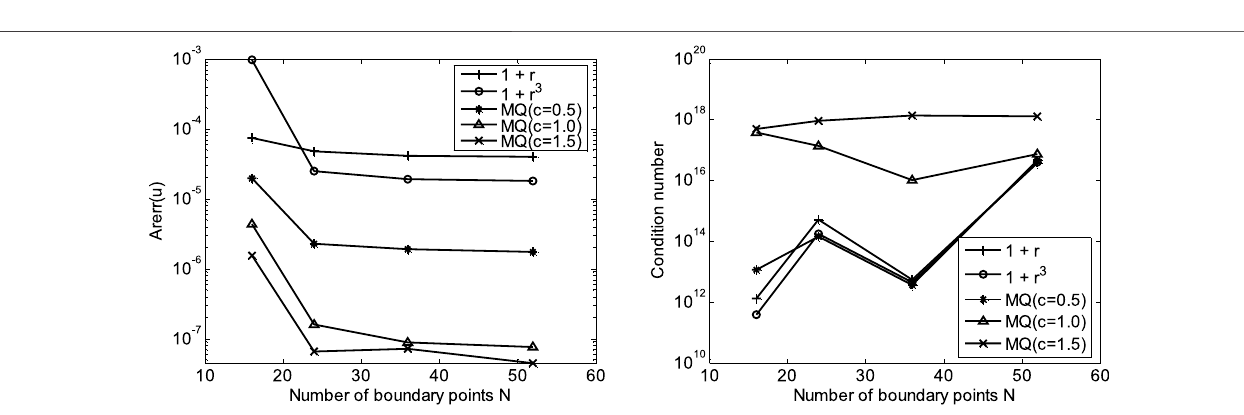
FIGURE 2 | Effect of different interpolating schemes with boundary interpolating points and without boundary interpolating points.